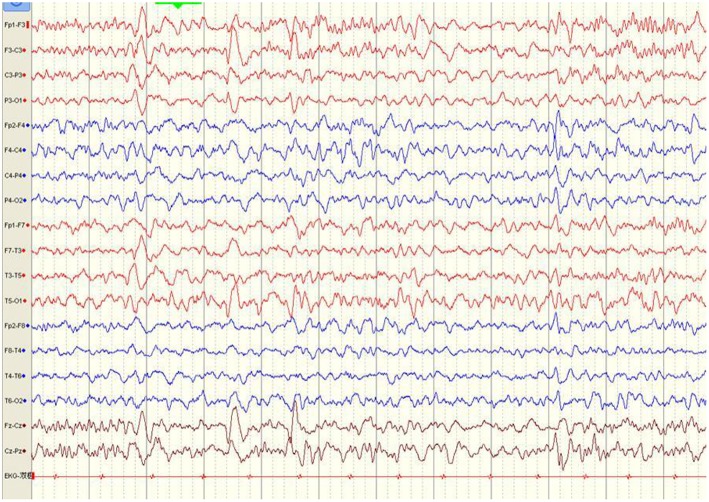
Normal EEG was recorded six months after immunotherapy (Case 8).